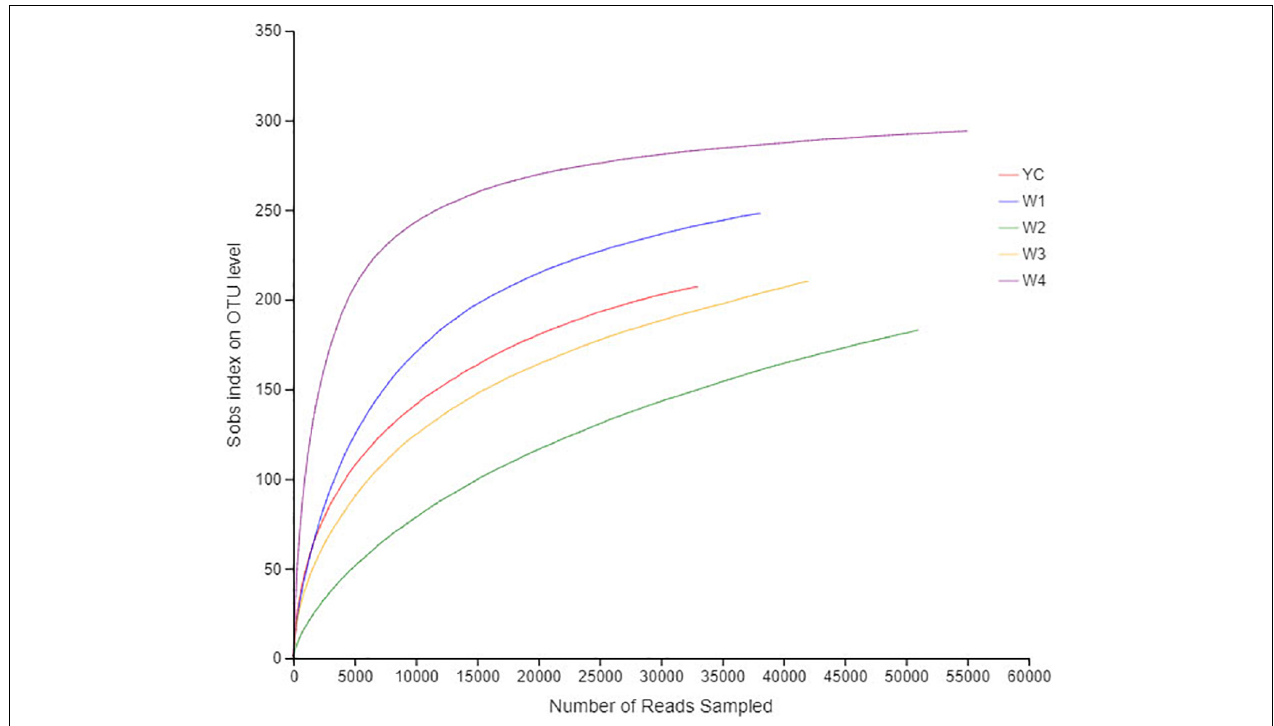
FIGURE 1 | Rarefaction curves of all samples. The abscissa represents the amount of randomly selected sequencing data; the ordinate represents the number of species observed. The flat curve shows that the amount of sequencing data for this study is sufficient.